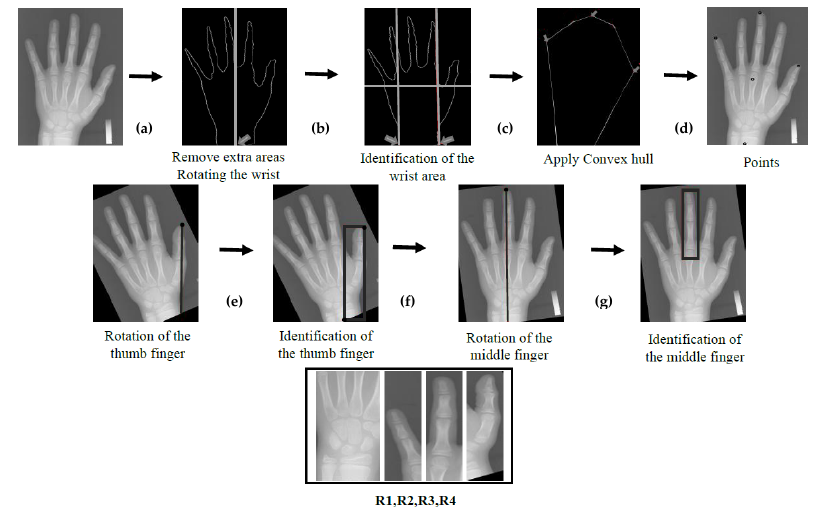
Figure 2. Preprocessing-Extraction of ROI Regions.